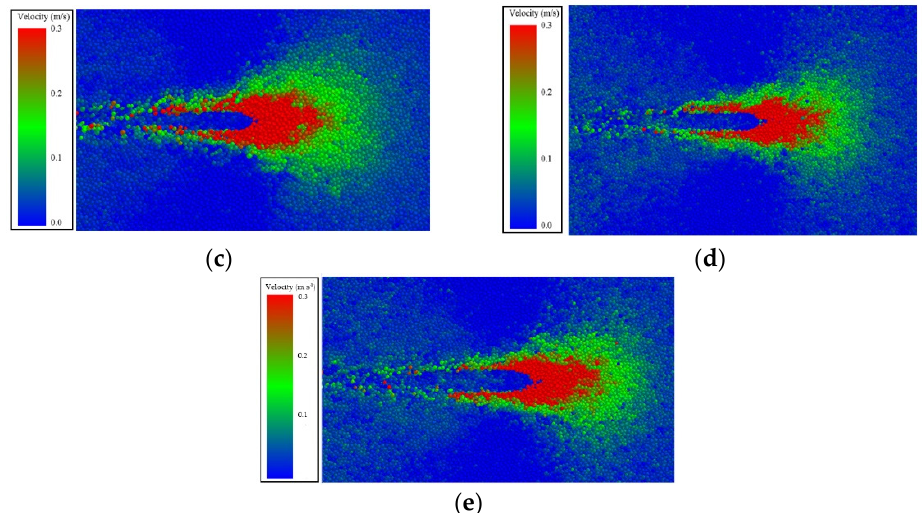
Figure 17. Top view of 80 mm depth profile at 10 km h − 1 (colour scale indicates velocity distribution). ( a ) Su 0 operation; ( b ) Su 1 operation; ( c ) Su 2 operation; ( d ) Su 3 operation; ( e ) Su 4 operation.